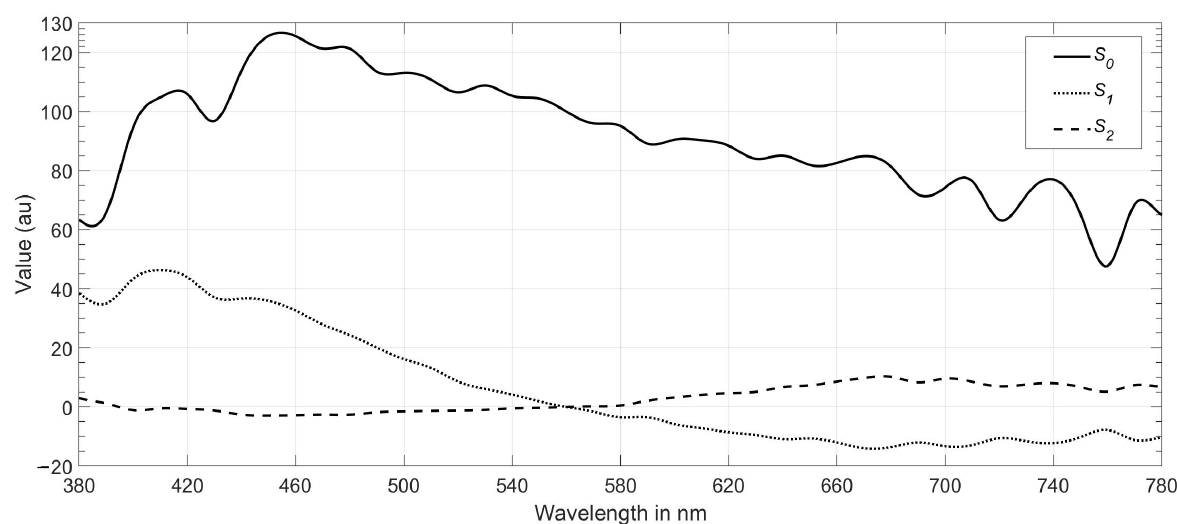
Figure 8. Basic functions S 0 ( λ ) , S 1 ( λ ) , and S 2 ( λ ) of the CIE daylight model after